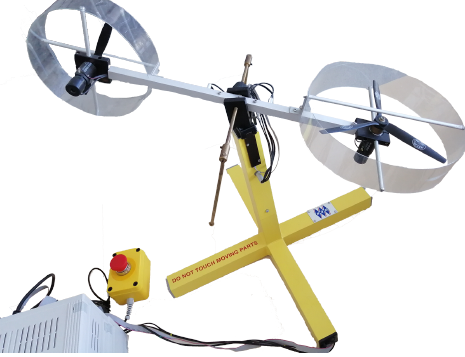
Figure 1. A nonlinear twin-rotor MIMO